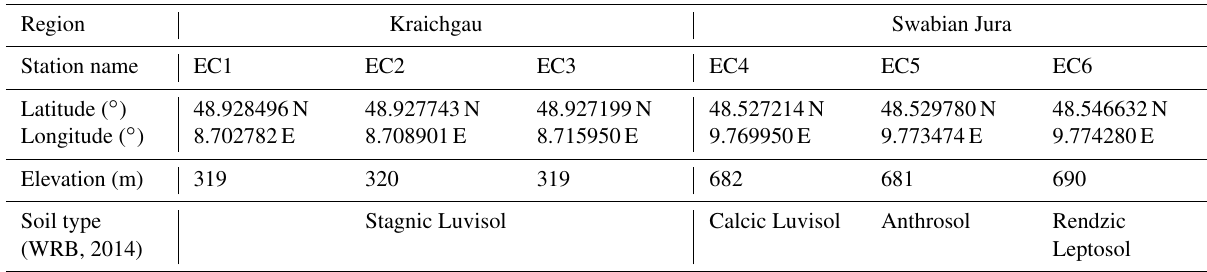
Table 1. Main characteristics of the investigated sites. Region